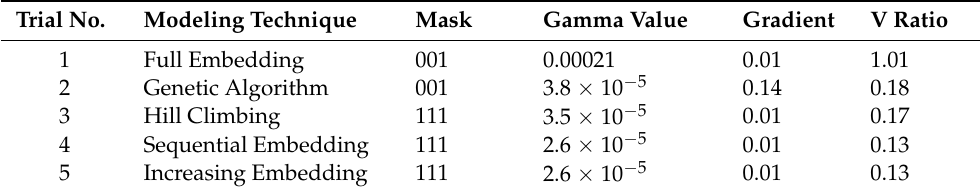
Figure 3. Gamma values for different model identification techniques. Table 3. Combination masks with Gamma values and other